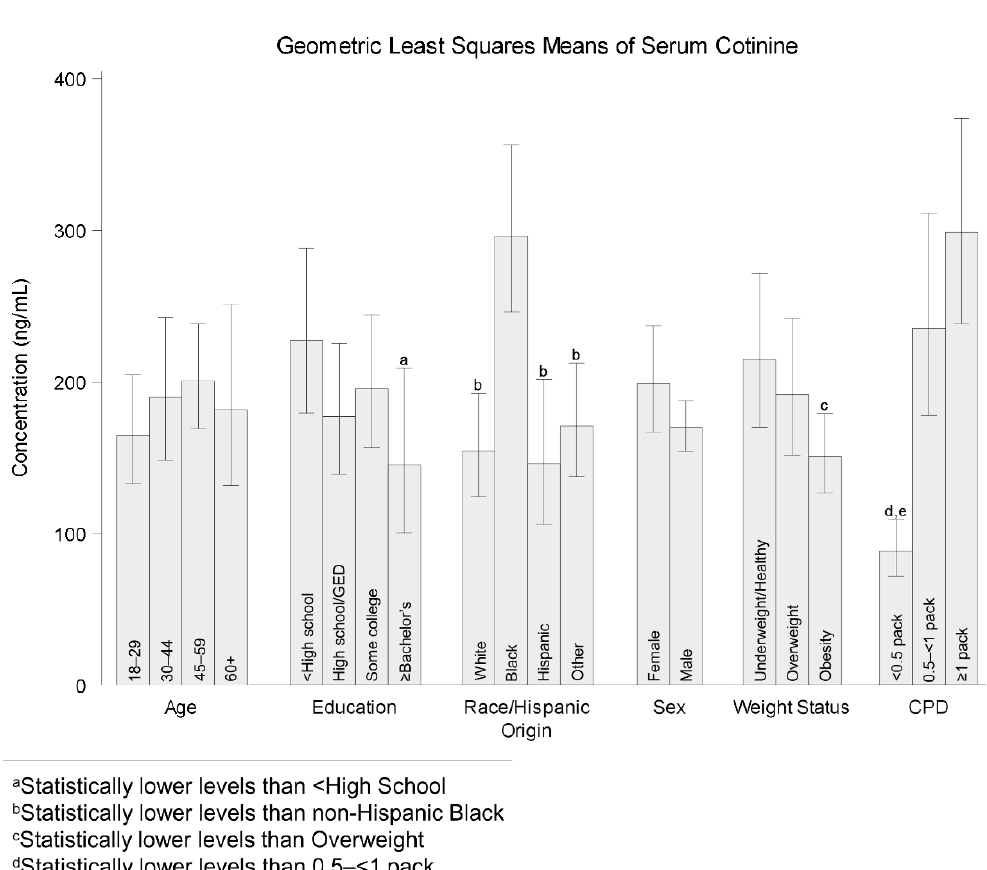
Figure A1. Geometric least squares means and 95% confidence intervals of serum cotinine by demographic characteristics. Geometric least squares means and p -values were calculated from natural log-transformed biomarker concentrations.